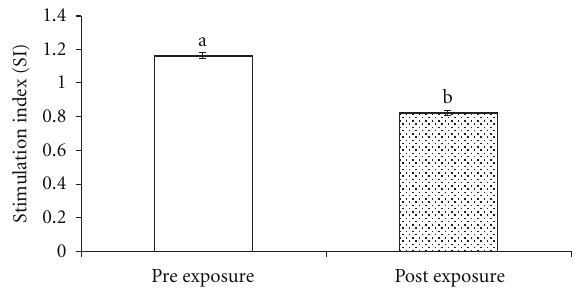
Figure 3: Mitogen-induced stimulation index in bu ff aloes after exposed to acute heat stress. Values are mean ± SEM. Bars with values in di ff erent groups that lack a commonletter are significantly di ff erent ( P < . 05).